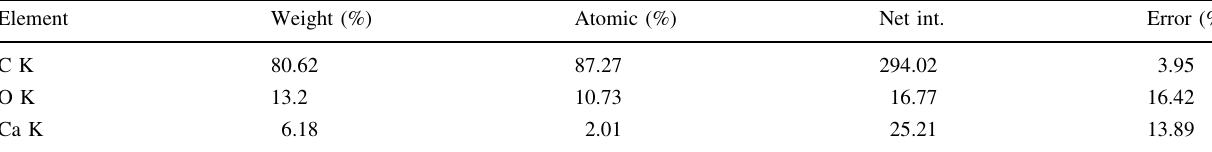
Table 1 Various elements present onto the tea waste biomass surface before surface modification Element